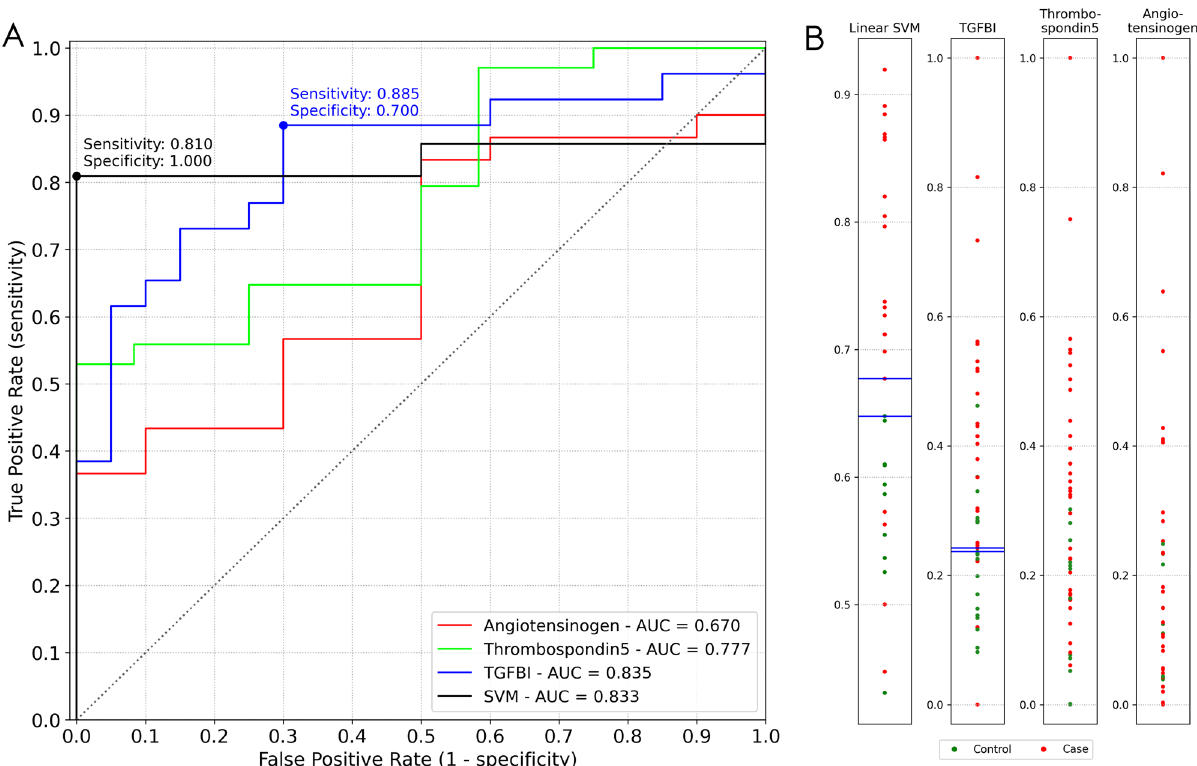
Figure 5. ROC curves assessing the diagnostic profiles of ig-h3 (TGFBI), thrombospondin 5 (COMP) and angiotensinogen (AGT) and a linear SVM model using all three features. Dots represent the decision thresholds yielding the most promising classifiers for the TGFBI and SVM predictors ( A ). One-dimensional sample distributions. For the single feature distributions, values were [0,1]-transformed. For the SVM distribution, calculated class probabilities for the class "case" were plotted ( B ). Blue lines mark samples for each group which are closest to the respective optimal decision thresholds of ( A